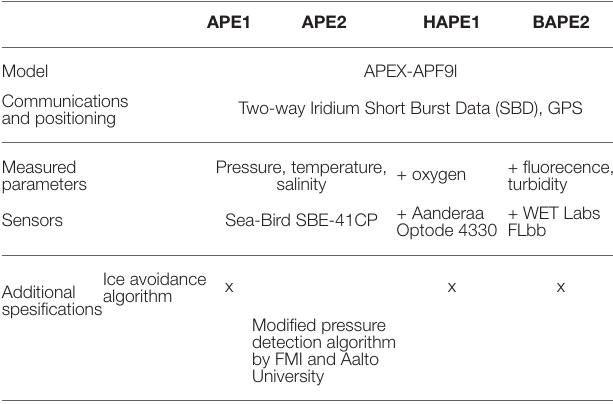
TABLE 1 | Details of the Argo floats used in the Bothnian Sea